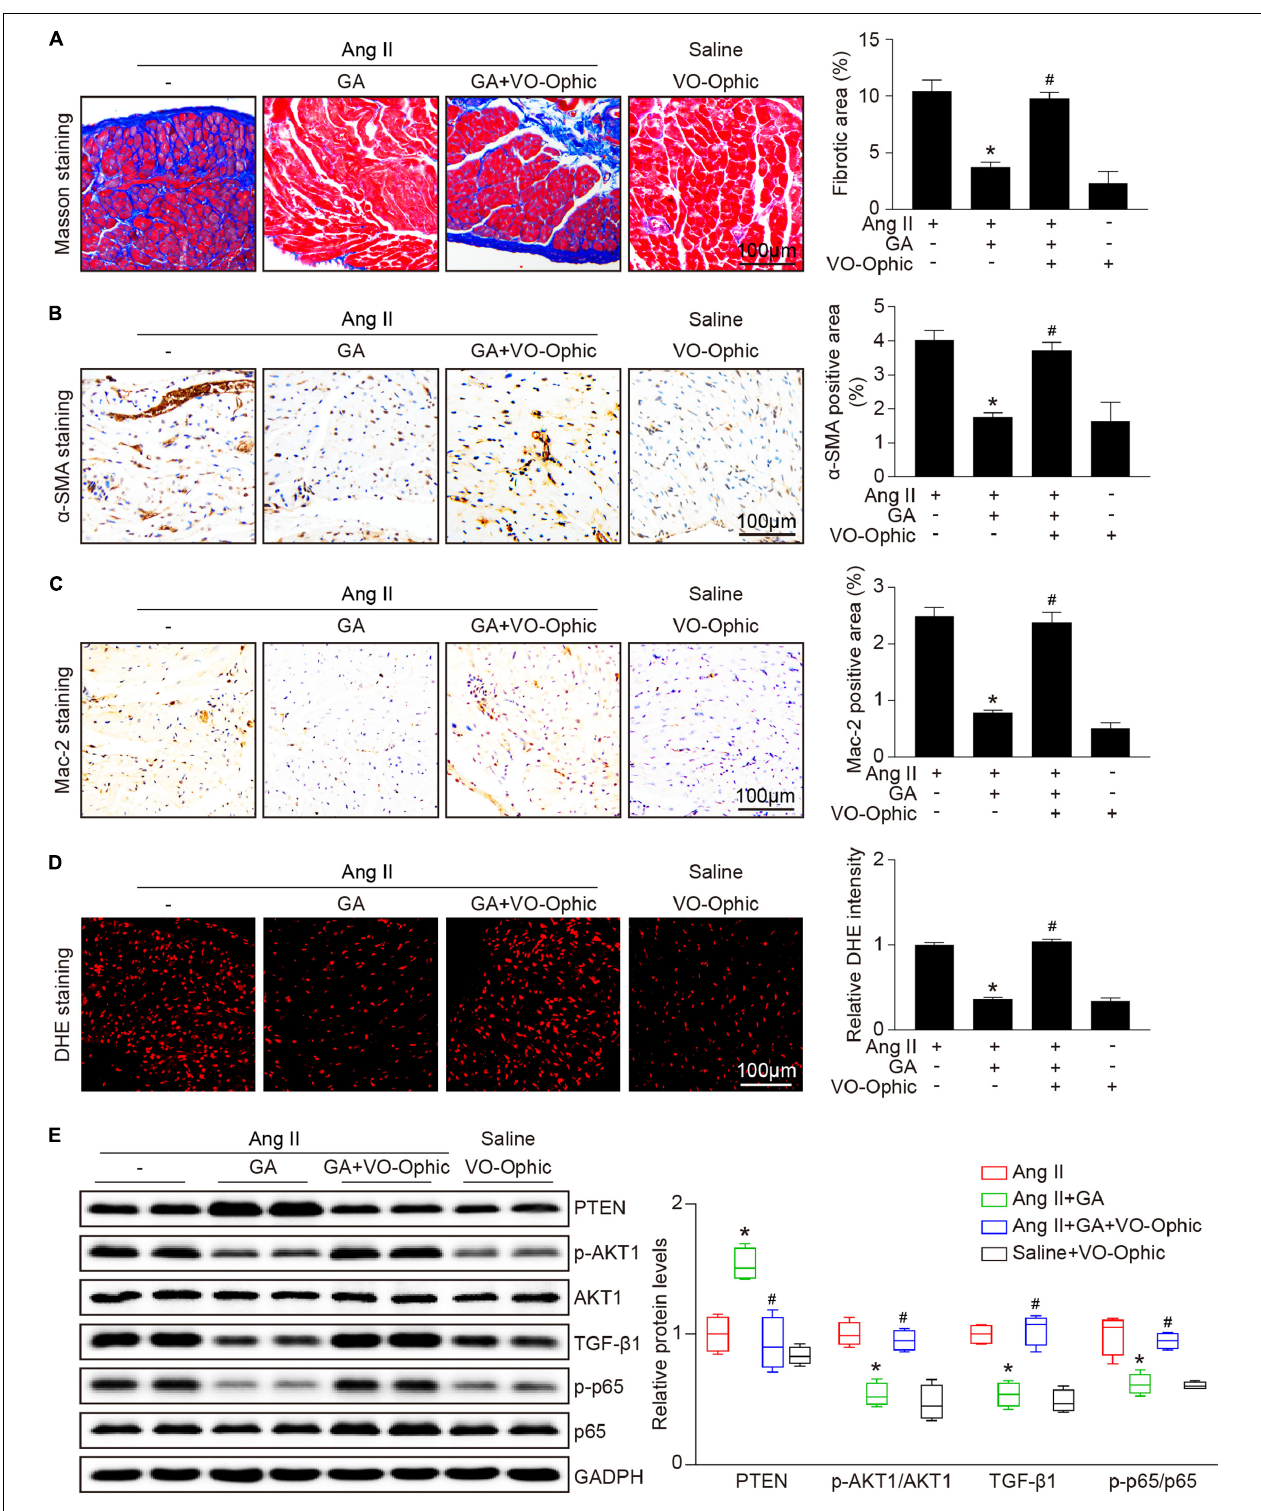
FIGURE 6 | PTEN inhibition blocks the GA-mediated protective effect on atrial remodeling and downstream signaling pathways. (A) Representative images of Masson trichrome staining for atrial fibrosis (left). Quantification of fibrotic area (right, n = 6). Scale bar: 100 µ m. (B) Representative images of immunohistochemical staining of LA sections to detect myofibroblast activation (left). Quantification of α -SMA + areas (right, n = 6). Scale bar: 100 µ m. (C) Representative Mac-2